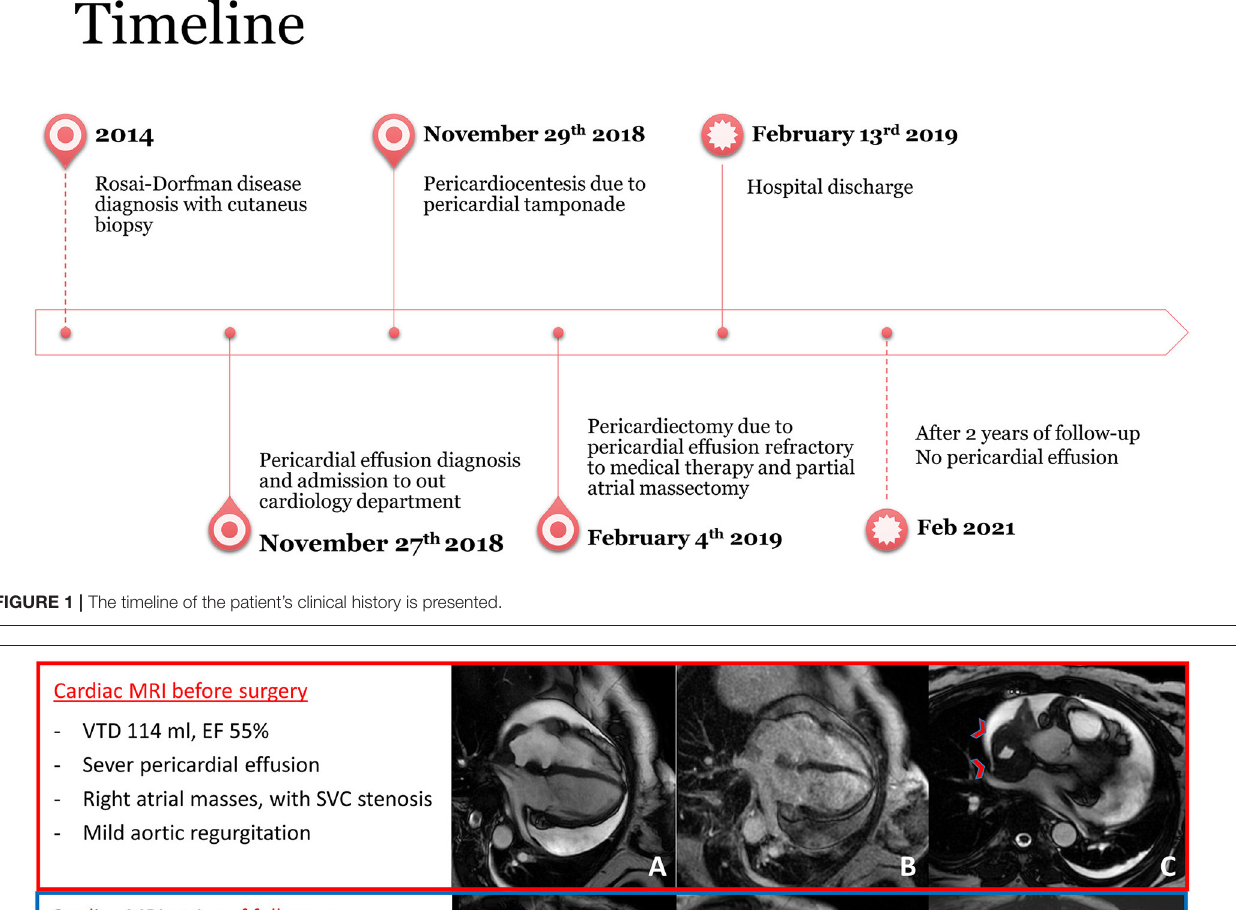
FIGURE 2 | Cardiac MRI at presentation showed severe pericardial effusion with mild aortic regurgitation (A) , right atrial masses with LGE (B) , and mass infiltration of the superior cava vein causing stenosis [red arrow-heads in (C) ]. After 1 year of follow-up, cardiac MRI showed no pericardial effusion with moderate mitro-aortic regurgitation (D) and mild increase in right atrial masses’ size (E) , but with no superior cava vein stenosis [red arrow-heads in (F)